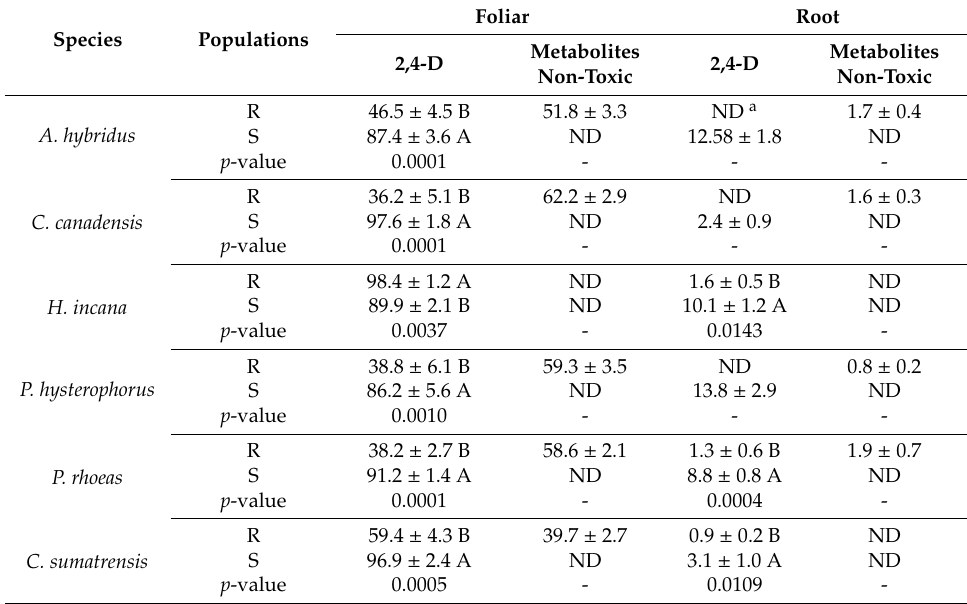
Table 4. 2,4-D metabolism (expressed as %) in di ff erent dicotyledonous weeds R and S populations at 96 h after treatment